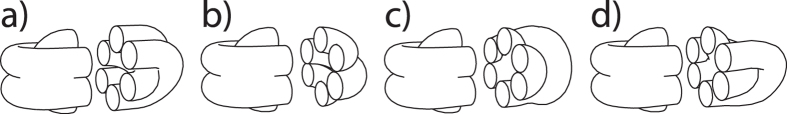
Four different closures of the three-toroids motif resulting in shapes having a single, closed centroid curve.